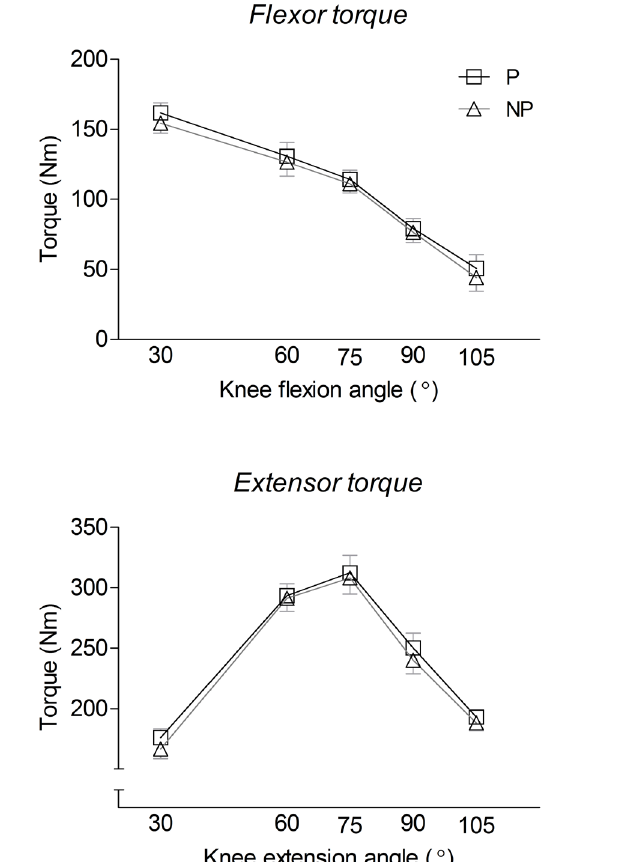
Figure 1. Torque-angle relationship for knee flexors (top) and extensors (bottom) during isometric